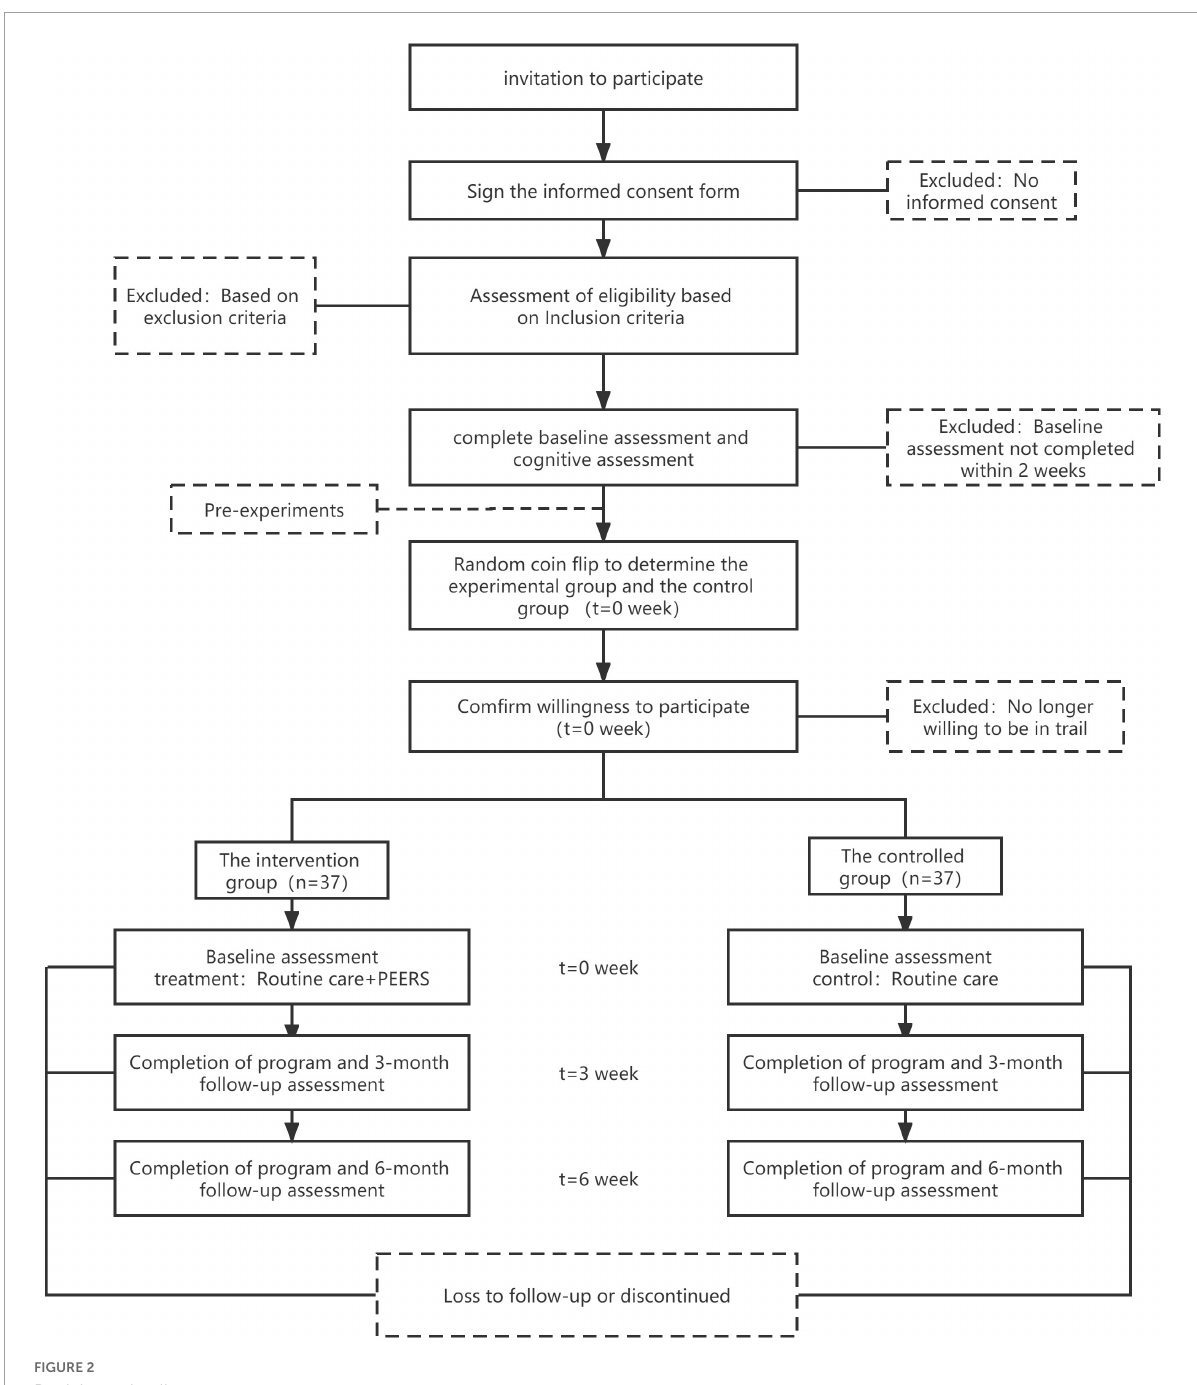
FIGURE2 Participant